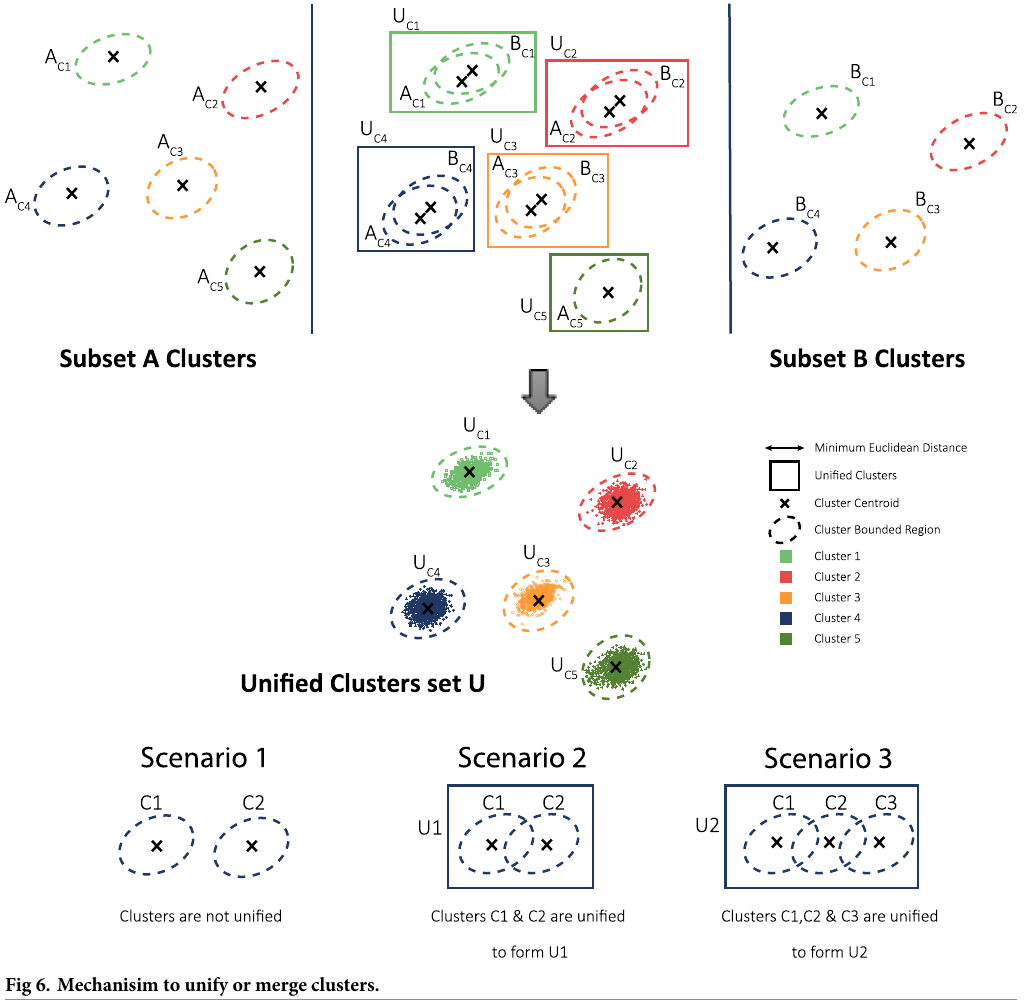
Fig 6. Mechanisim to unify or merge